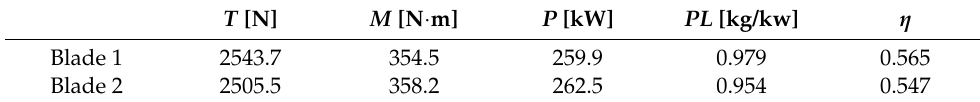
Figure 5. The profile parameters distributions of the two blades.